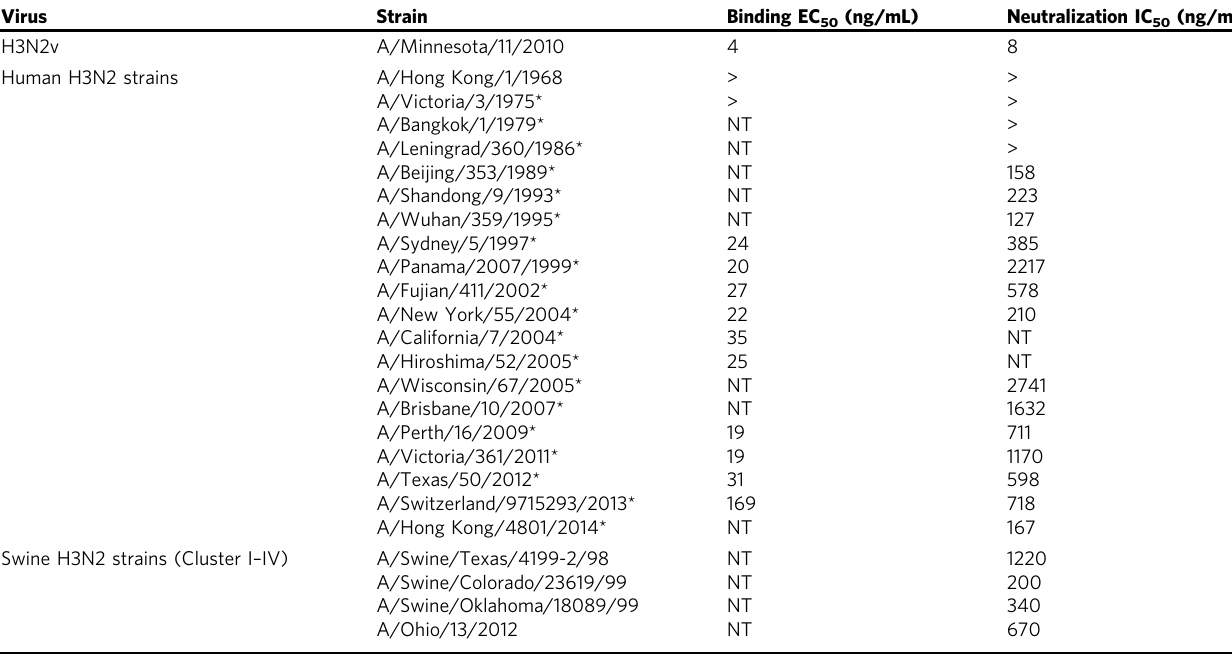
Table 1 H3v-47 IgG breadth of HA binding and virus neutralization for human or swine H3N2 viruses